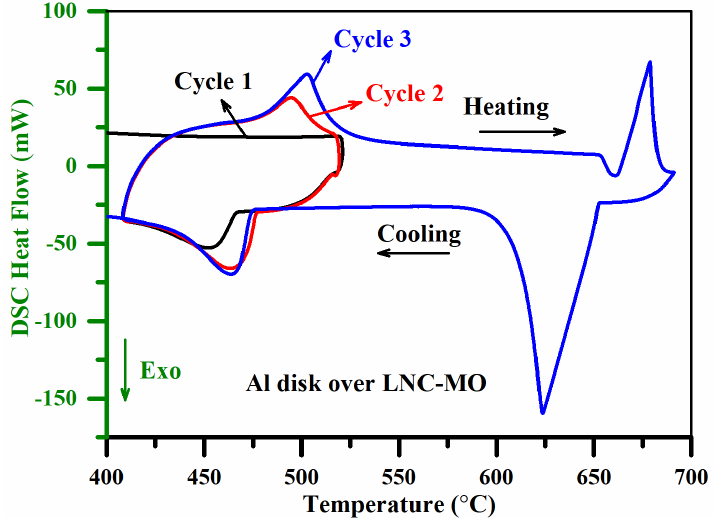
Figure 2. Influence of the thermal cycles and reduction in thermal contact resistance.